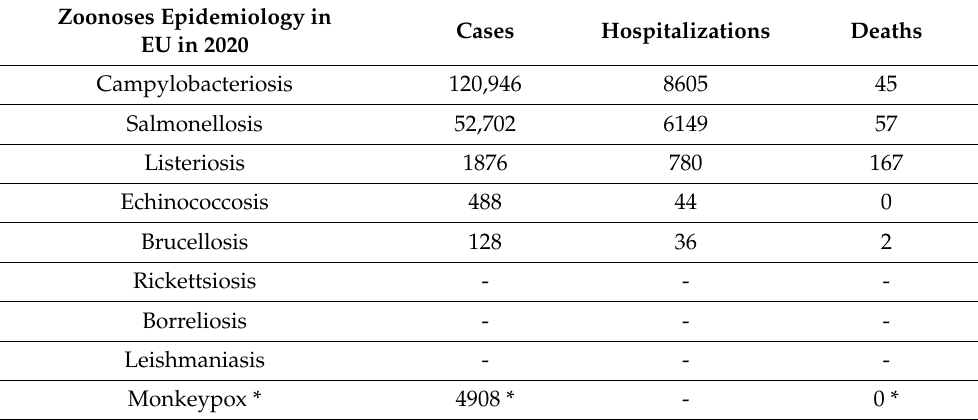
Table 1. Epidemiology of some of the most common zoonoses in European countries as reported by the ECDC bulletin, referring to 2020 (note: monkeypox epidemiology updated to 7 July 2022). Zoonoses Epidemiology